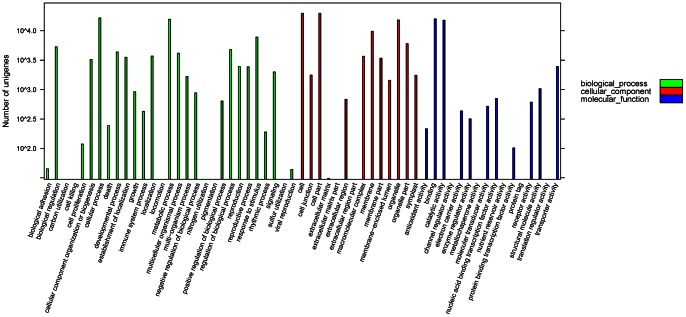
Gene Ontology classification of assembled unigenes.Total 29,666 unigenes were categorized into three main categories: Biological process (81,460, 40.21%), Cellular component (83,650, 41.29%) and Molecular function (37,497, 18.51%).